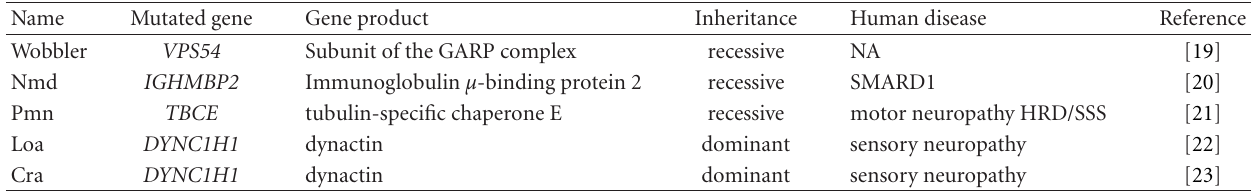
Table 1: Overview of spontaneous or induced mouse models showing motor neuron degeneration.